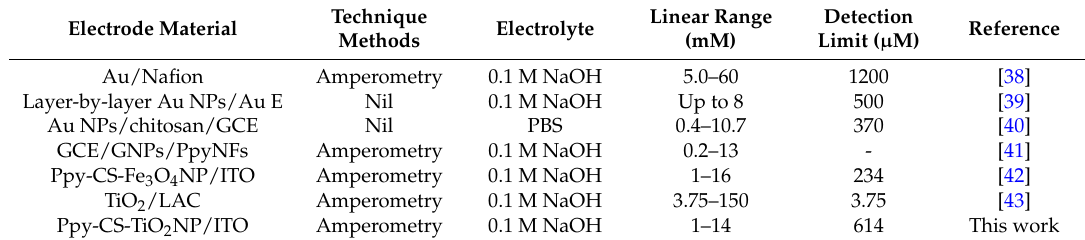
Table 1. Performance parameters obtained from different electrodes based on non-enzymatic glucose